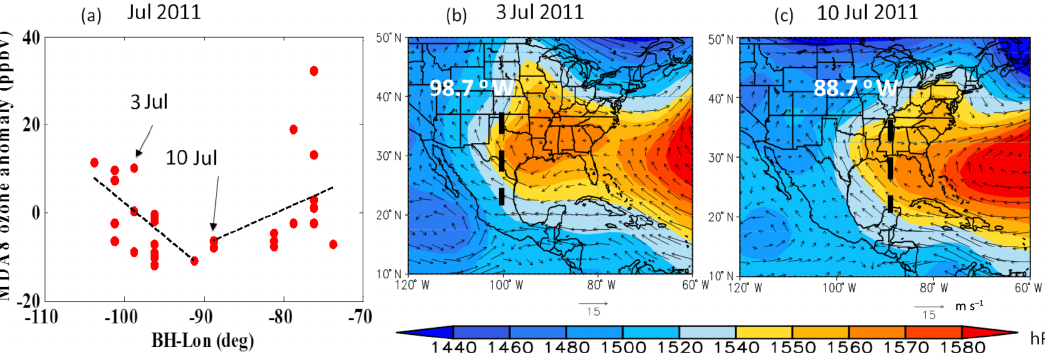
Figure 9. (a) Relationship between daily ozone anomaly ( y axis) and daily BH-Lon ( y axis) for July 2011. ( b – c ) Distribution of SLP (color contours) and 850hPa wind fields (arrows) on 3 July (b) and 10 July 2011 (c) . The black dashed line shows the longitude of the BH-Lon (values shown in